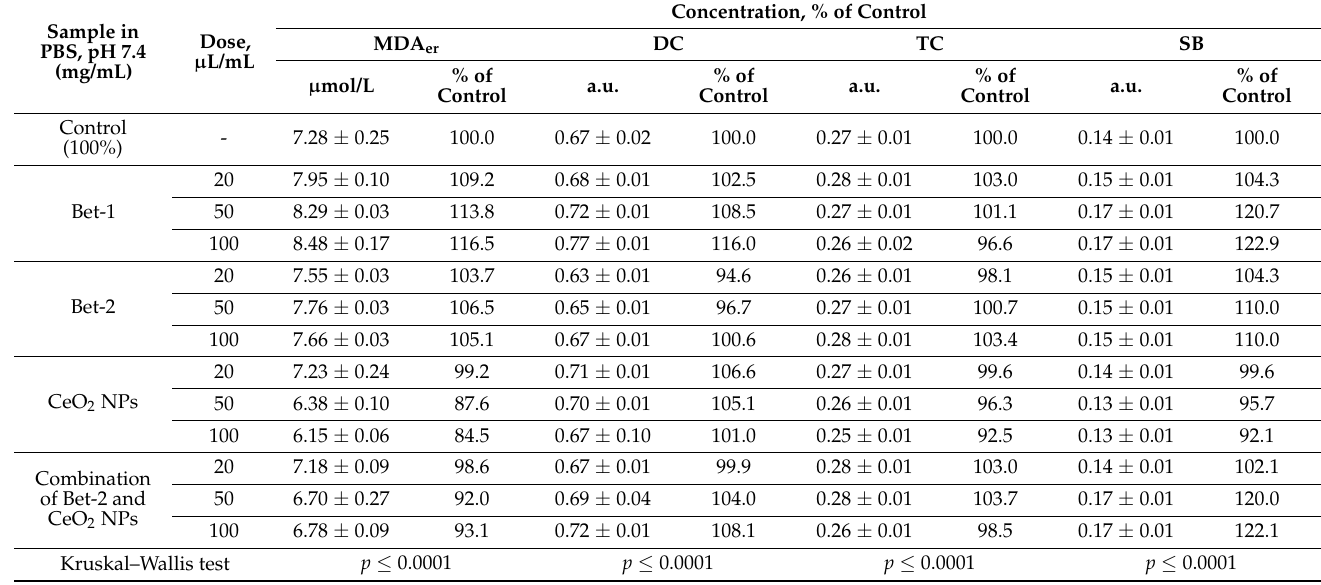
The antioxidant properties of the studied Bet-1 and Bet-2 copolymers, as well as their combination with CeO 2 NPs, were also evaluated using the biochemical parameters of lipid peroxidation (LPO), such as the level of malonic dialdehyde (MDA) in the erythrocytes, diene and triene conjugates, and Schiff bases (Table 5). Table 5. Levels of malonic dialdehyde, diene and triene conjugates, and Schiff bases in the blood of rats under the action of the studied compounds at the doses of 20, 50, and 100 µ L of the sample per 1 mL of blood as a percentage relative to the control (n = 3) 1